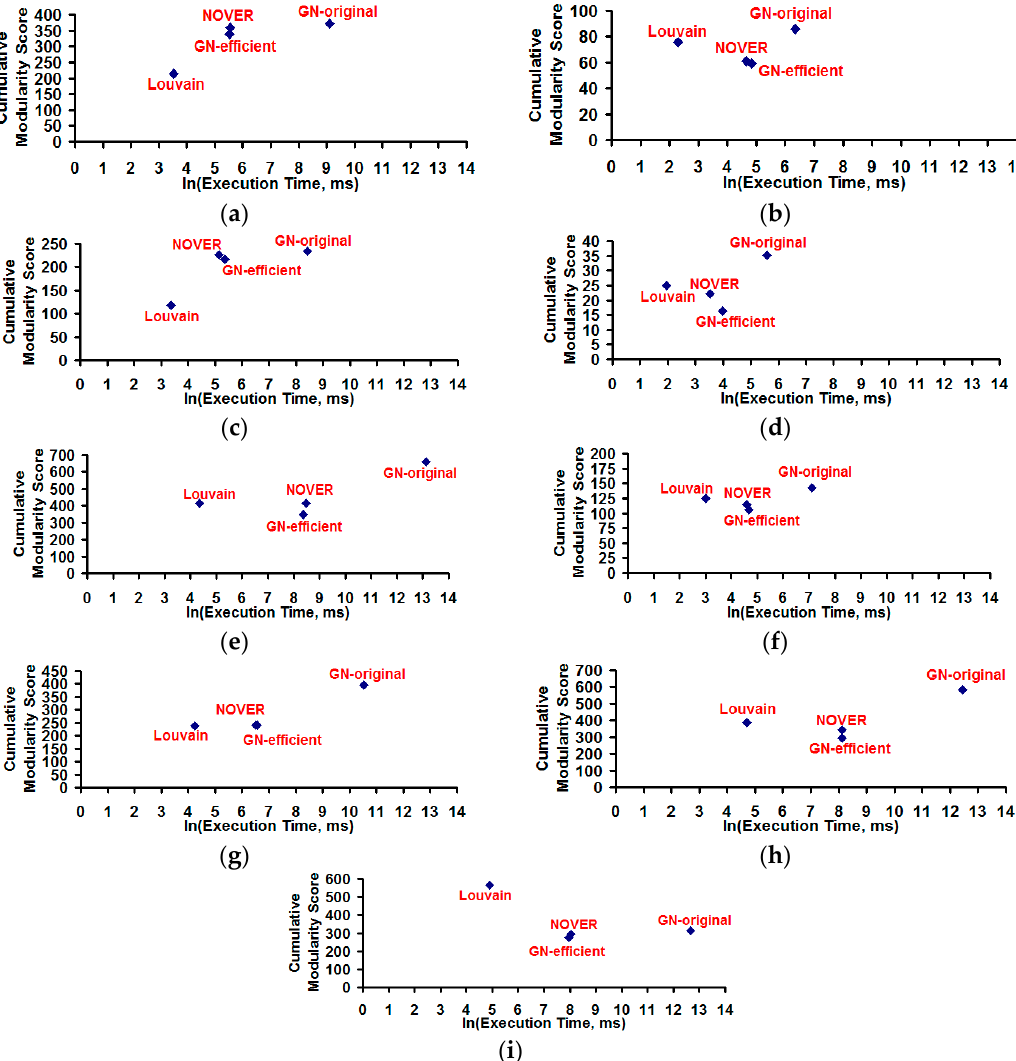
Figure 9. Cumulative modularity score vs. execution time for the community detection algorithms on real-world Networks graphs. ( a ) US FOOTBALL Network (FN); ( b ) Dolphin Network (DN); ( c ) US Politics Book Network (PN); ( d ) Karate Network (KN); ( e ) C. Elegans Network (NN); ( f ) Les Miserables Network (LN); ( g ) Citation GD Network (CN); ( h ) Erdos971 Collaboration Network (EN); ( i ) US Airports Network (AN).